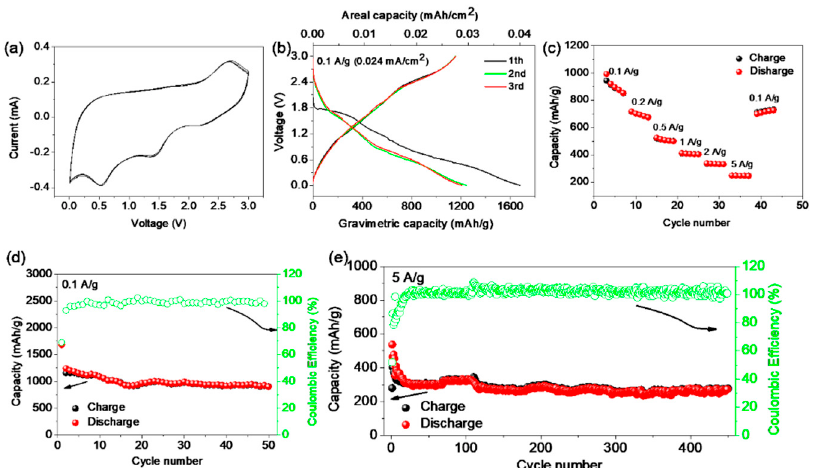
Figure 4. The electrochemical performances of S-GDY electrodes in Li metal half-cell format: ( a ) the first three cyclic voltammetry (CV) curves at a scan rate of 1 mV/s, ( b ) galvanostatic charge–discharge profiles at a current density of 0.1 A/g (0.024 mA cm − 2 ), recorded between 5 mV and 3 V, ( c ) the rate performance, ( d ) the cycle performance at the current density of 0.1 A g − 1 , and ( e ) the cycle performance at the current density of 5 A g − 1 .